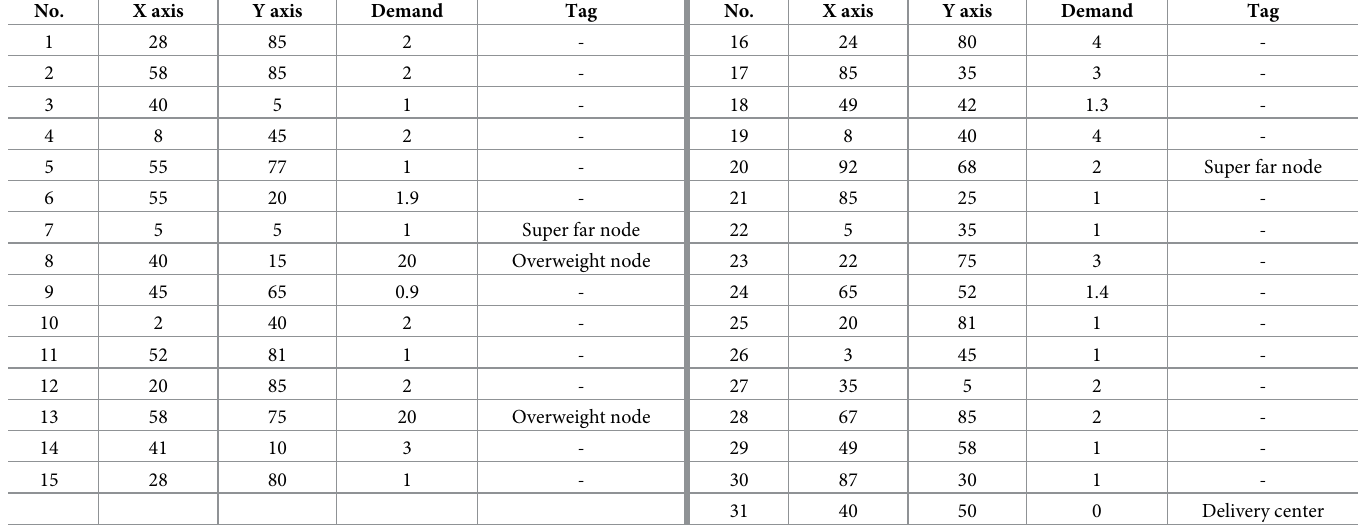
Table 2. Data of each node.